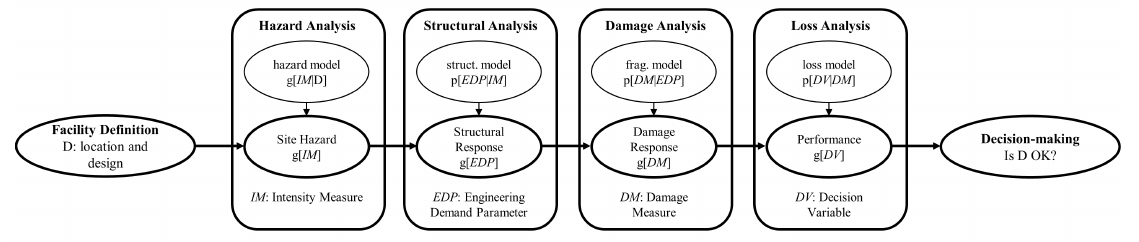
Figure 1. PBEE framework, adapted from